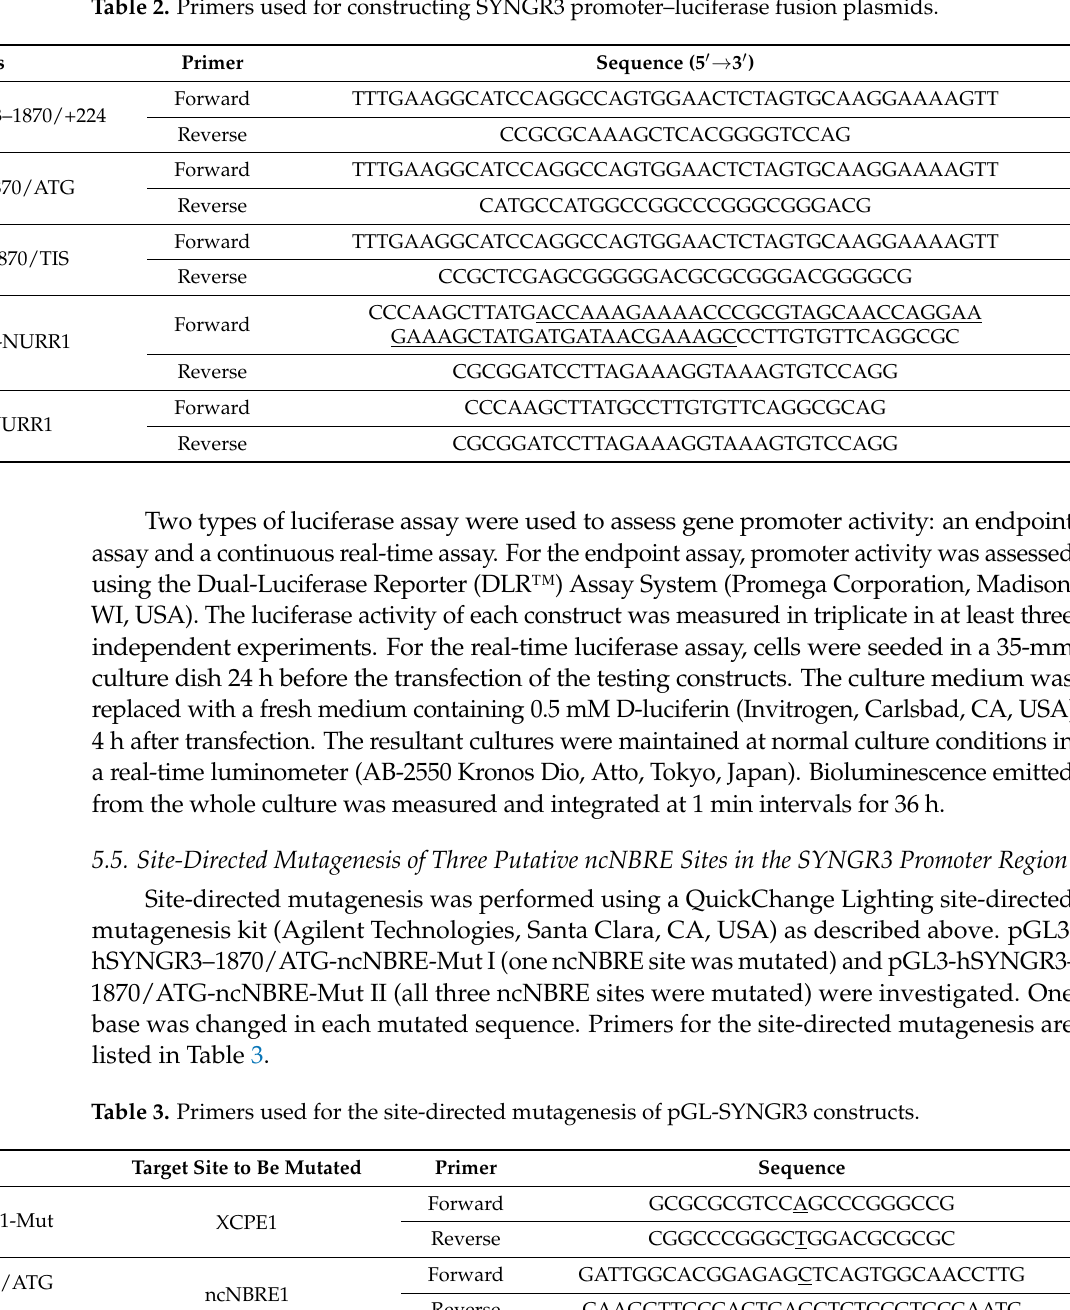
Table 2. Primers used for constructing SYNGR3 promoter–luciferase fusion plasmids.